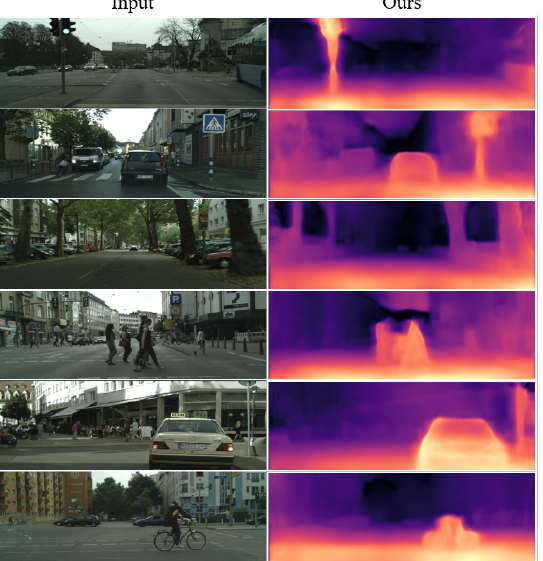
Figure 3. Qualitative results on CityScapes dataset for verifying our model’s generalization